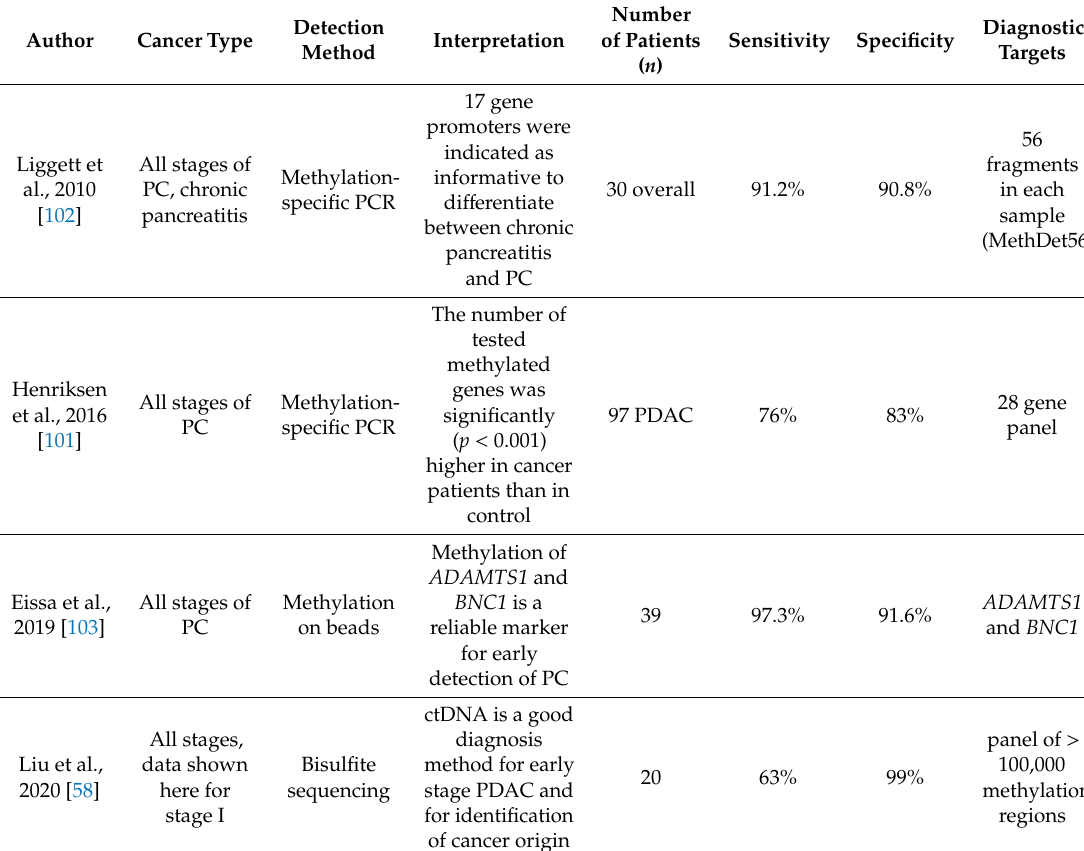
Table 2. Selected methylation studies of ctDNA in pancreatic